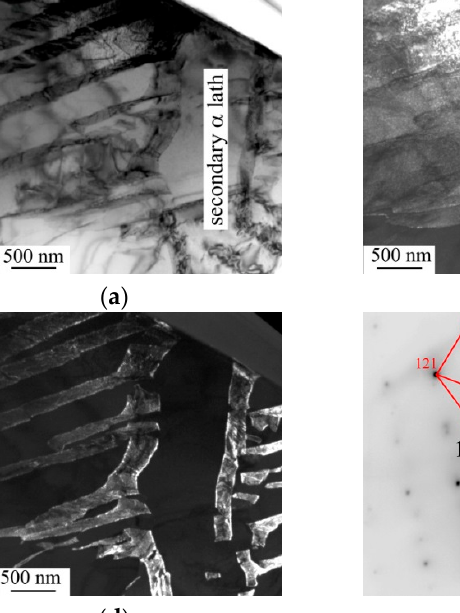
Figure 5. Microstructure within the outermost surface area ( a,b ) and the core region ( c ) of the EBF 3 -fabricated Ti–6Al–4V sample in the as-built state.